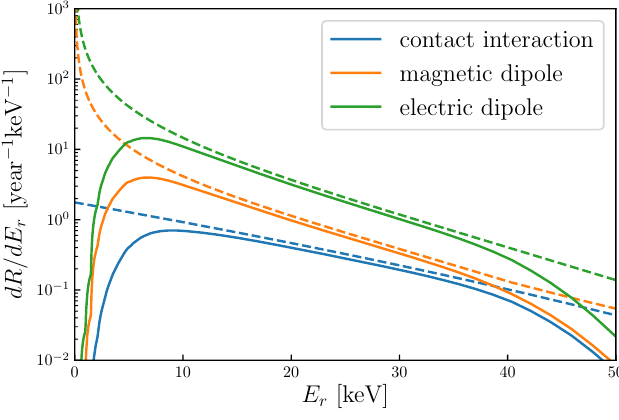
Figure 2 . Results of g ( v min ) and h ( v min ) in eqs. (5.12) and (5.13).